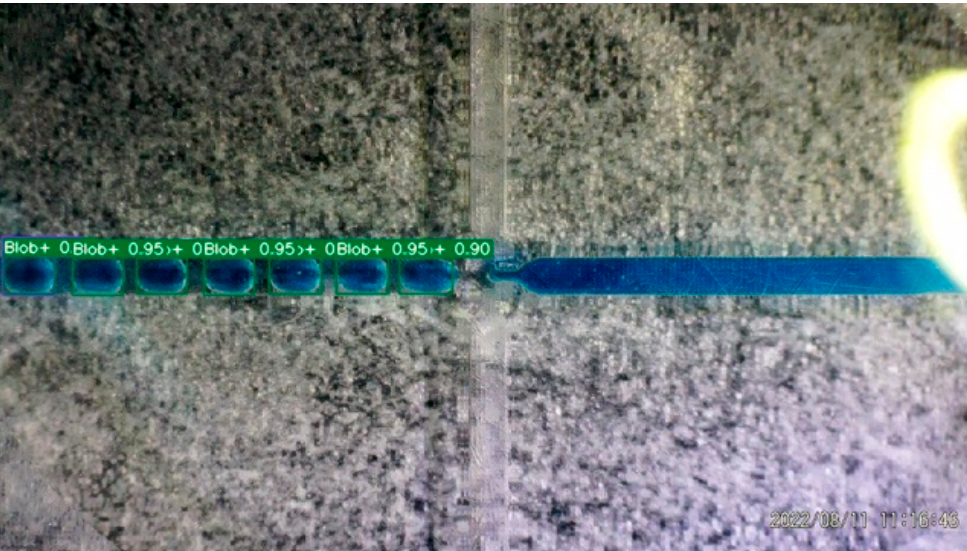
Figure 9. The monodisperse droplet detection sample on real data from a digital microscope.